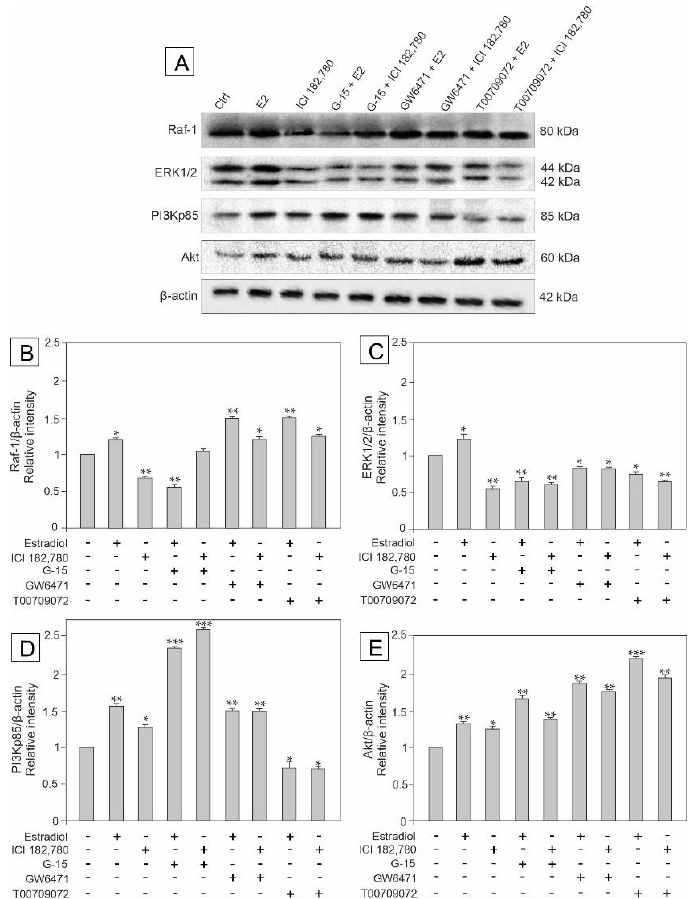
Figure 5. The effect of estradiol (E2), GPER agonist (ICI 182,780), GPER antagonist (G-15), PPAR α antagonist (GW6471), and PPAR γ antagonist (T00709072) on Raf-1, ERK 1/2, PI3Kp85, and Akt protein expression in MA-10 cells ( A – E ). Representative blots of Western analysis ( A ) and relative expression of the proteins ( B – E ). Cells were harvested after 24 h. Untreated cells served as a control. Protein levels within control cells were given a value of 1. The cropped blots are displayed and the original blots are provided in Supplementary Materials (Figure S1). The relative levels of the proteins were normalized to β -actin which served as internal protein loading control. The histograms are the quantitative representation of data (mean ± SD) of three independent experiments, each in triplicate ( B – E ). A plus sign (+) indicates the presence of the compound in the culture medium, a minus sign (–) indicates no compound in the culture medium. Asterisks indicate significant differences from control cells. Values are denoted as * p < 0.05, ** p < 0.01 and *** p <